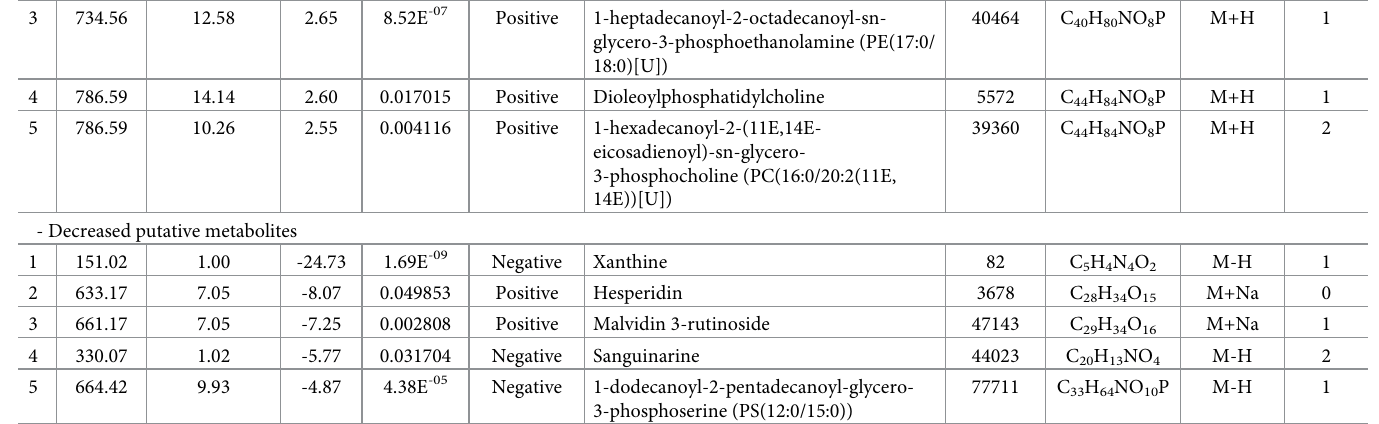
trypanosomiasis, and the complement and coagulation cascades were the top-3 pathways with highest impact and p- values of less than 0.05 (Fig 4D and S4 Table). Thiamine metabolism, type II diabetes mellitus, and primary bile acid biosynthesis were the top-3 affected pathways in sera of mice infected for 4 weeks (Fig 4E and S4 Table). At 8-weeks PI, the top-3 affected pathways were glycerophospholipid metabolism, arachidonic acid metabolism, and retrograde endocannabinoid signaling (Fig 4F and S4 Table). Additionally, the interconnection map was generated between affected pathways and their related counterparts to visualize the connection (S4 Fig). At all timepoints, most of identified pathways were connected directly or indirectly via their related pathways. These interconnections provided overview of consequences occurred from T . spiralis infection to host’s body. Among all affected pathways, the glycerophospholipid metabolism pathway was presented at all infection timepoints and had a high pathway impact and low p- value in both the metabo- lomic data alone and combined proteomic and metabolomic data analysis, especially at 2- and 8-weeks PI. Glycerophospholipids are a class of lipid species that are essential components of cell membranes and play vital roles in immune responses to infection. Changes in the levels of glycerophospholipids and other lipid classes may influence symptoms of disease and can be used as biomarkers for diagnosis. Therefore, we further explored the diagnostic potential of these lipid species with ROC curve analysis.